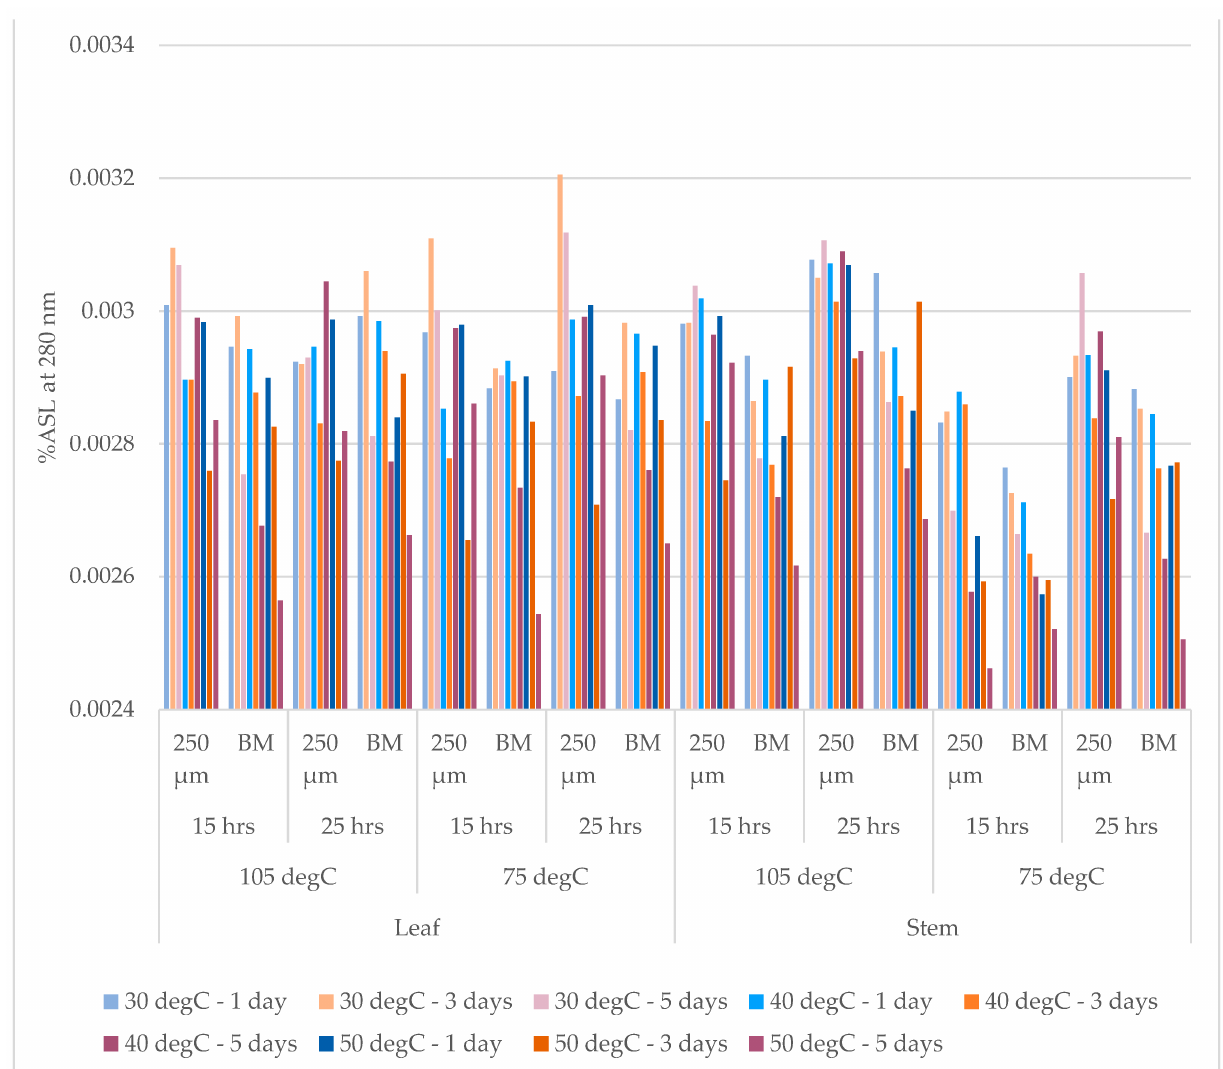
Figure 9. Soluble lignin content after enzymatic hydrolysis at 280 nm.